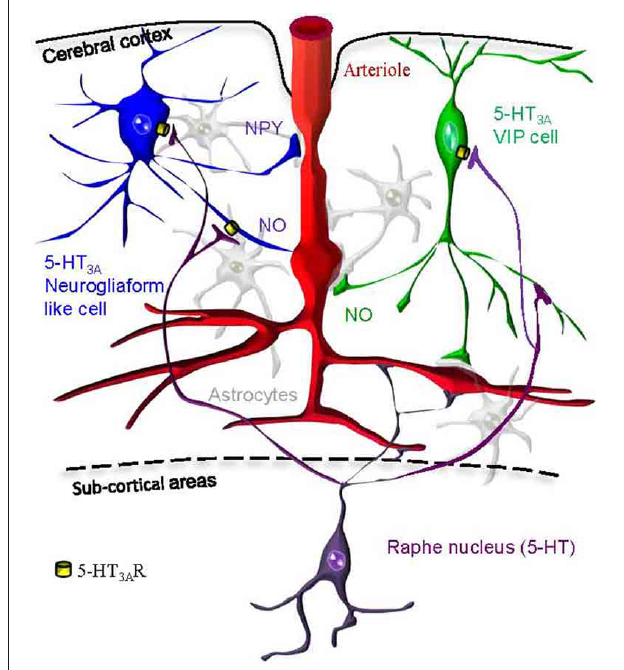
FIGURE 9 | Hypothetical schematic representation of the 5-HT 3A R induction of neurovascular coupling within the somatosensory cortex. We find that pharmacological stimulation of 5-HT 3A -expressing neurogliaform like cells (in blue) or VIP cells (in green) could either lead to vasodilation via NO release or vasoconstriction via NPY release. Cortical penetrating arterioles (in red) are also directly innervated by serotoninergic fibers originating from raphe nuclei (in purple). Astrocytes are shown in